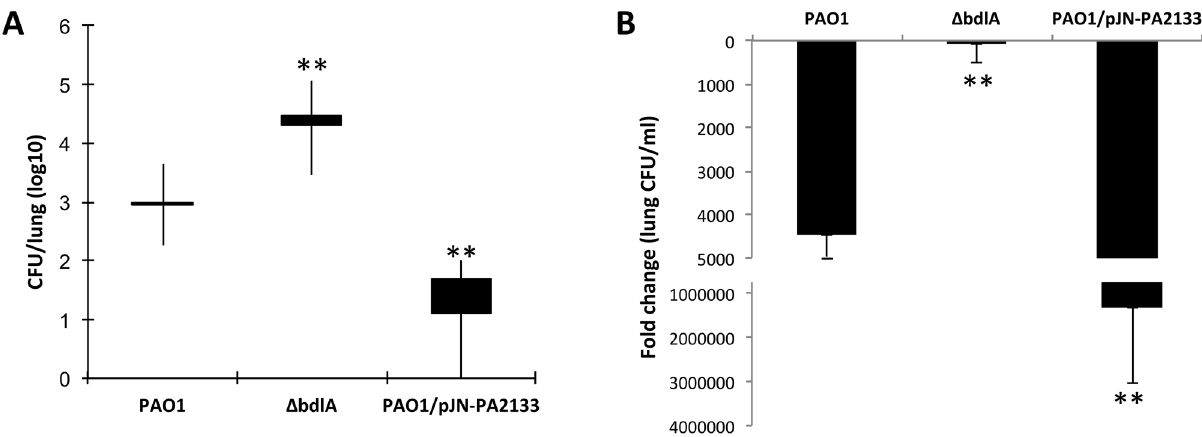
Figure 7. Impaired dispersion correlates with increased persistence as determined using a chronic murine pneumonia infection model. CD1 mice were inoculated intratracheal through oral lavage using feeding needle with 1.2 6 10 6 CFU of Pseudomonas strains. Lungs were harvested 14 days post-inoculation and CFU was determined. A total of 10 mice were used in per study. (A) Bacterial burden in the lung. Values presented are average, min, max, mean lung CFU/ml. (B) Fold change in lung CFU/ml 14 days post-infection compared to initial inoculum. Error bars indicate standard deviation. The values were tested by means of a Fisher test. **, significantly different from PAO1, P-value , 0.001.